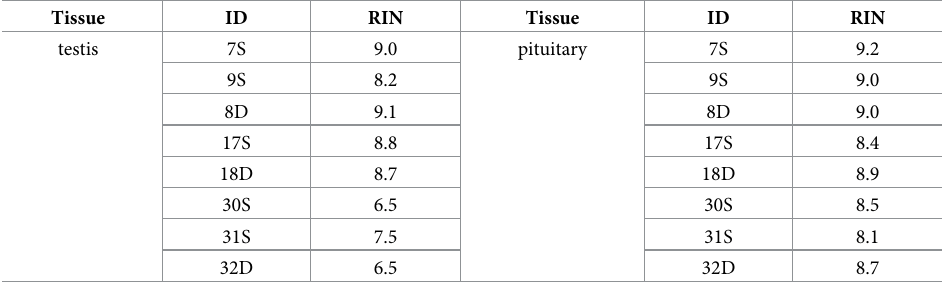
Table 1. RIN values of RNA from testes and pituitaries.